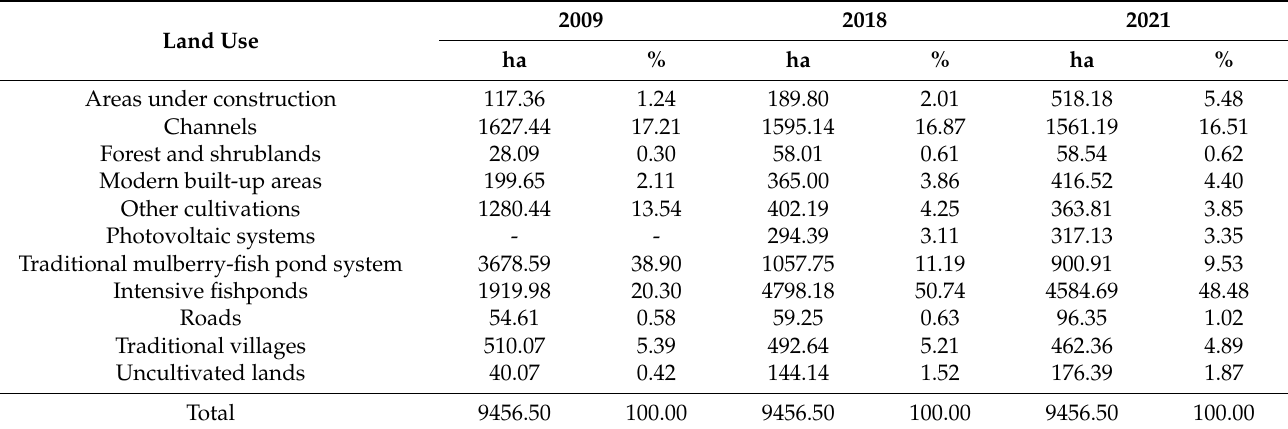
Table 3. Surface in hectares and percentages occupied by the different land uses in 2009, 2018, and